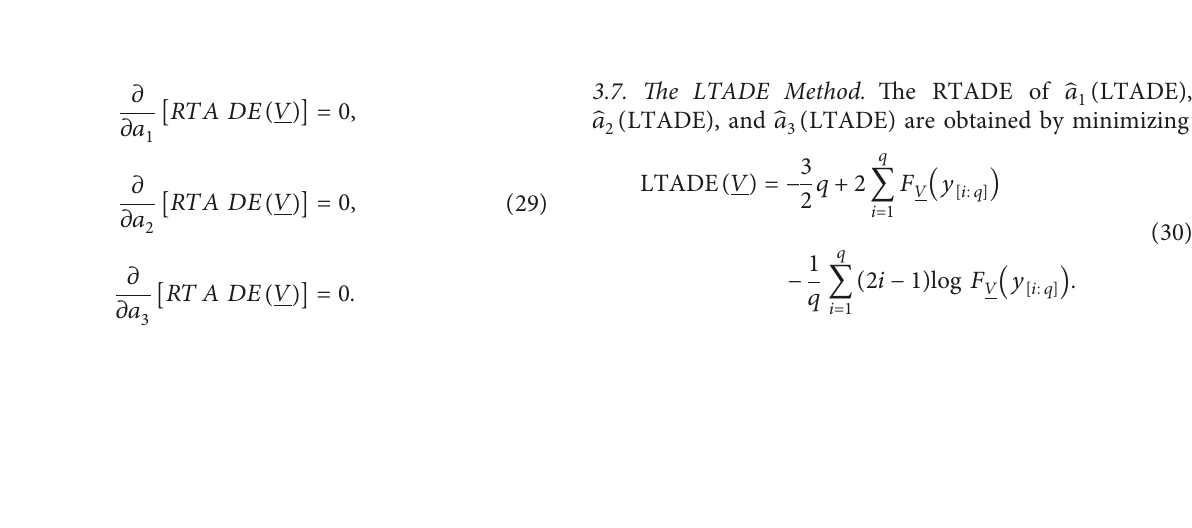
Figure 3: TTT plot, box plot, Q-Q plot, and KDE for stress data